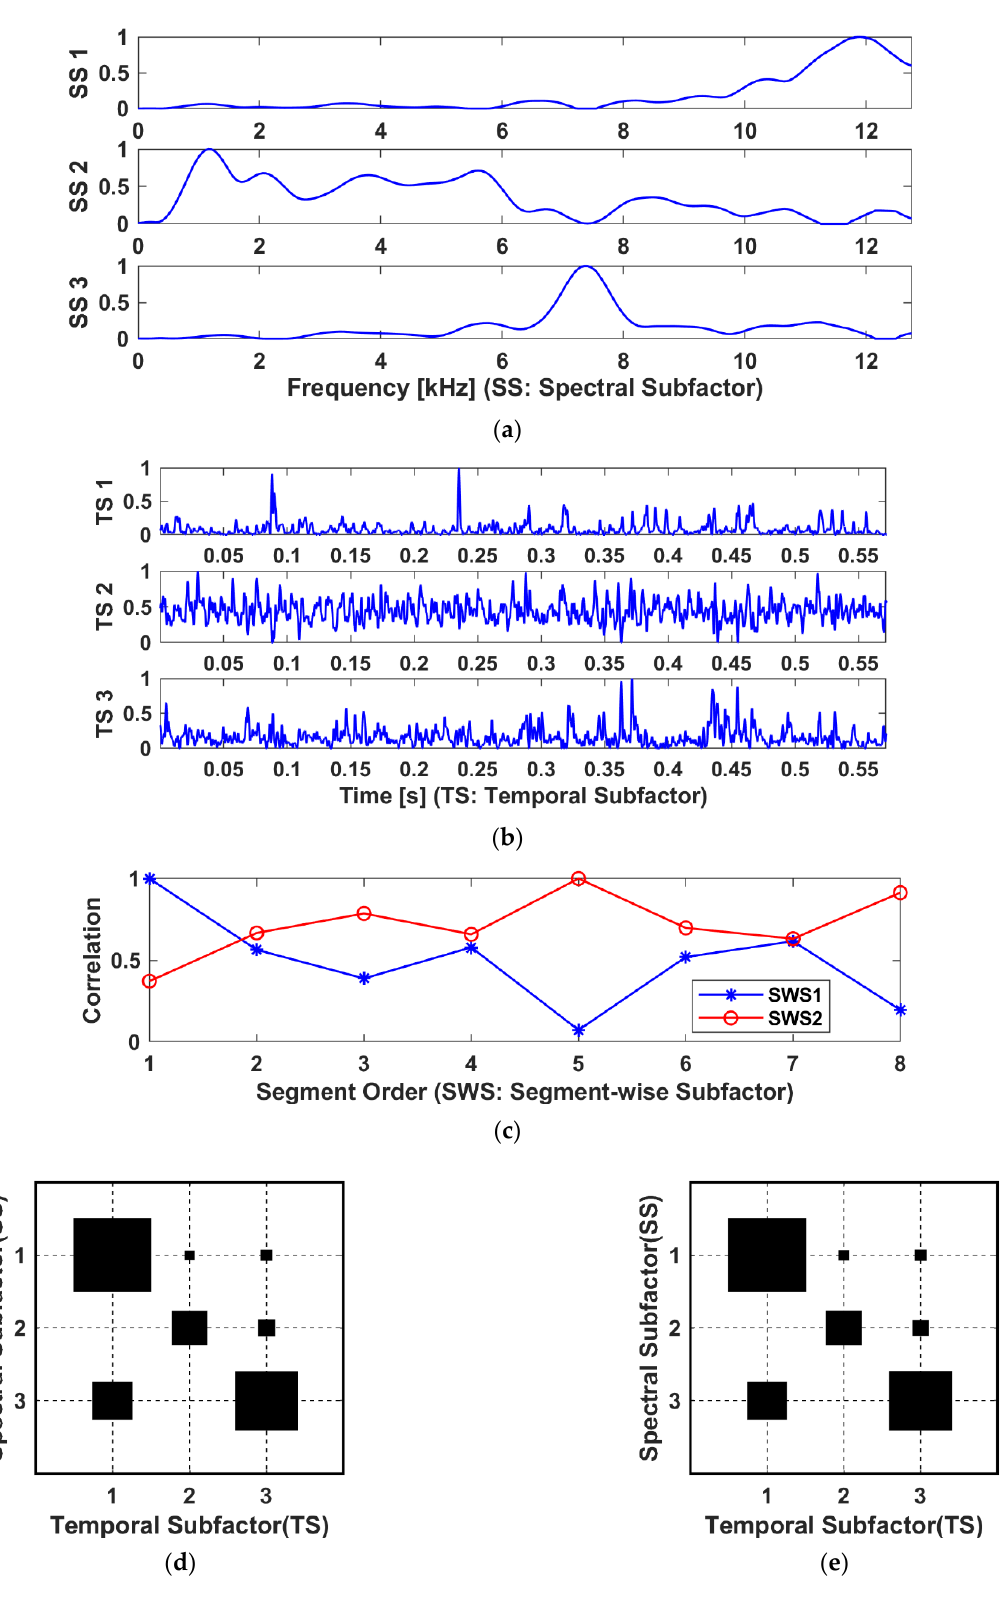
Figure 10. Factors of LRA-NTD: ( a ) Spectral Factor, ( b ) Temporal Factor, ( c ) Segment-wise Factor, and ( d ) the Core Tensor represented via the frontal slice 1 and ( e ) the frontal slice